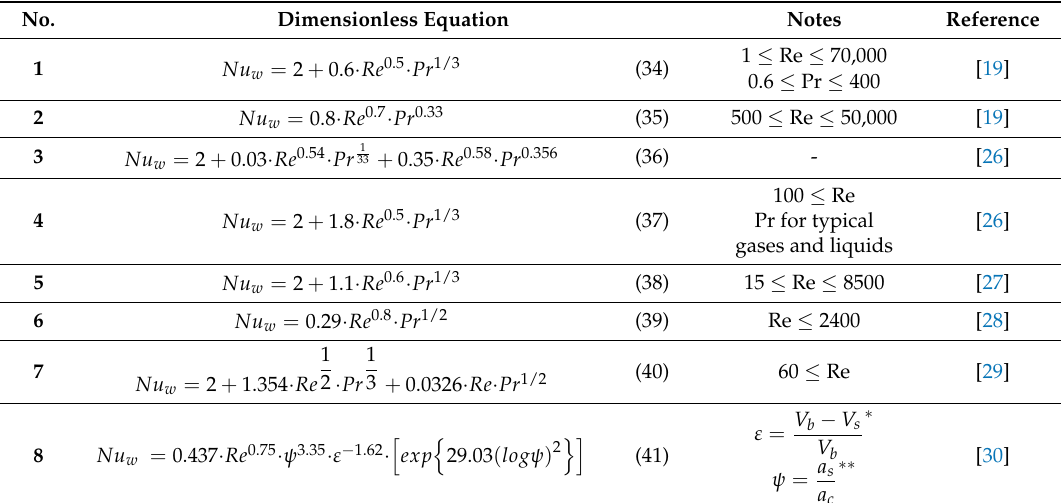
Table 2. Selected Nusselt number formulas.